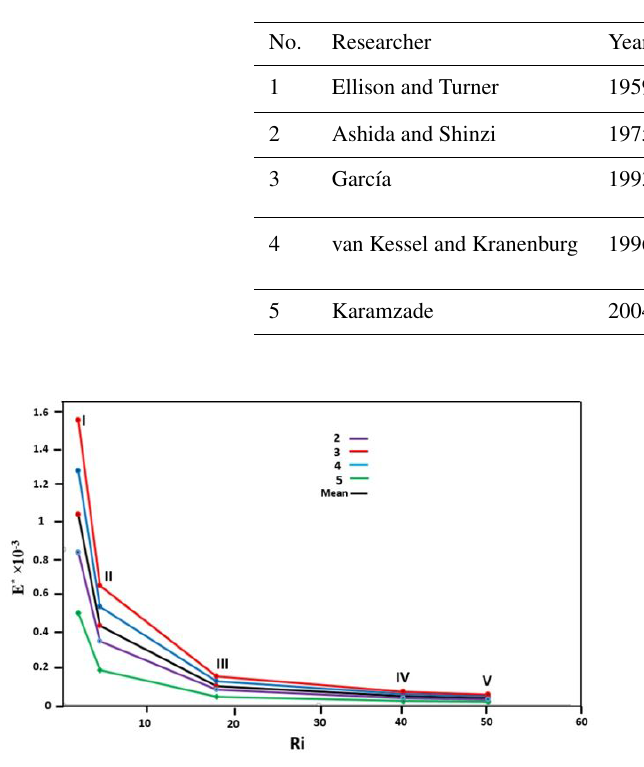
Figure 11. Changes of entrainment coefficients based on different Richardson numbers for May in the transects shown in Fig. 1b. The formulas in Table 2 are used to estimate E ∗ (the numbers refer to the equation numbers in Table 2). To use E ∗ in Eqs. (1) and (2) (Sect. 3.2), the mean values for E ∗ is also estimated